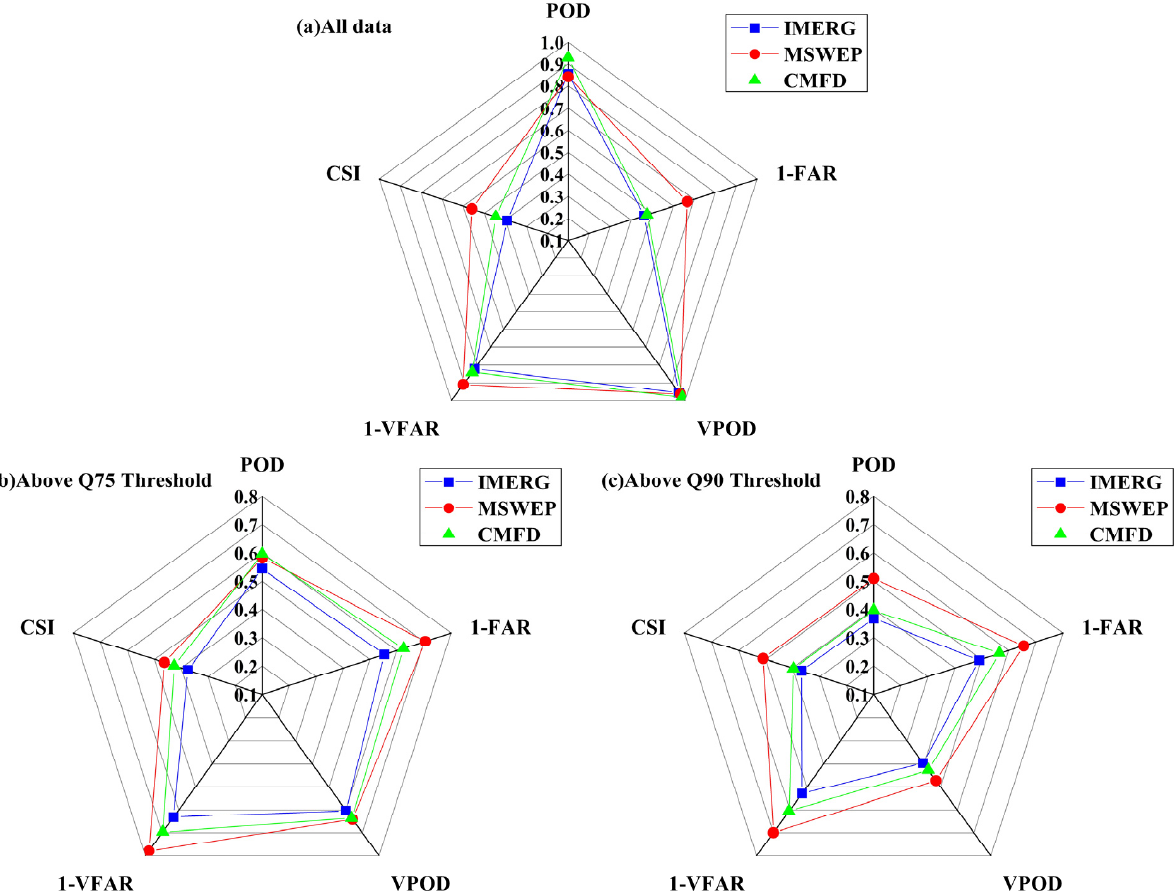
Figure 2. Capability of the satellite-derived precipitation products to capture precipitation with different thresholds: ( a ) all data, ( b ) above the Q75 threshold, and ( c ) above the Q90 threshold.